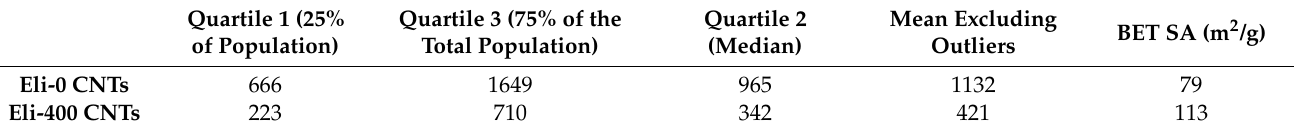
Table 1. Length distribution (nm) and BET surface area (SA) (m 2 /g) after ball milling of functionalized Elicarb CNTs.